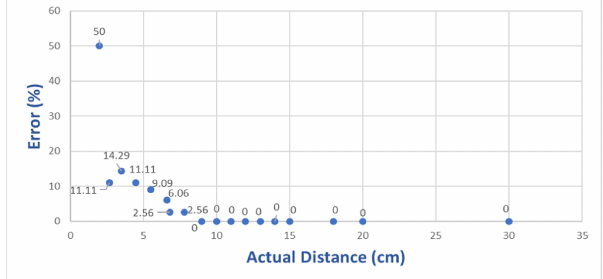
Fig. 11 Evaluation of error for metal